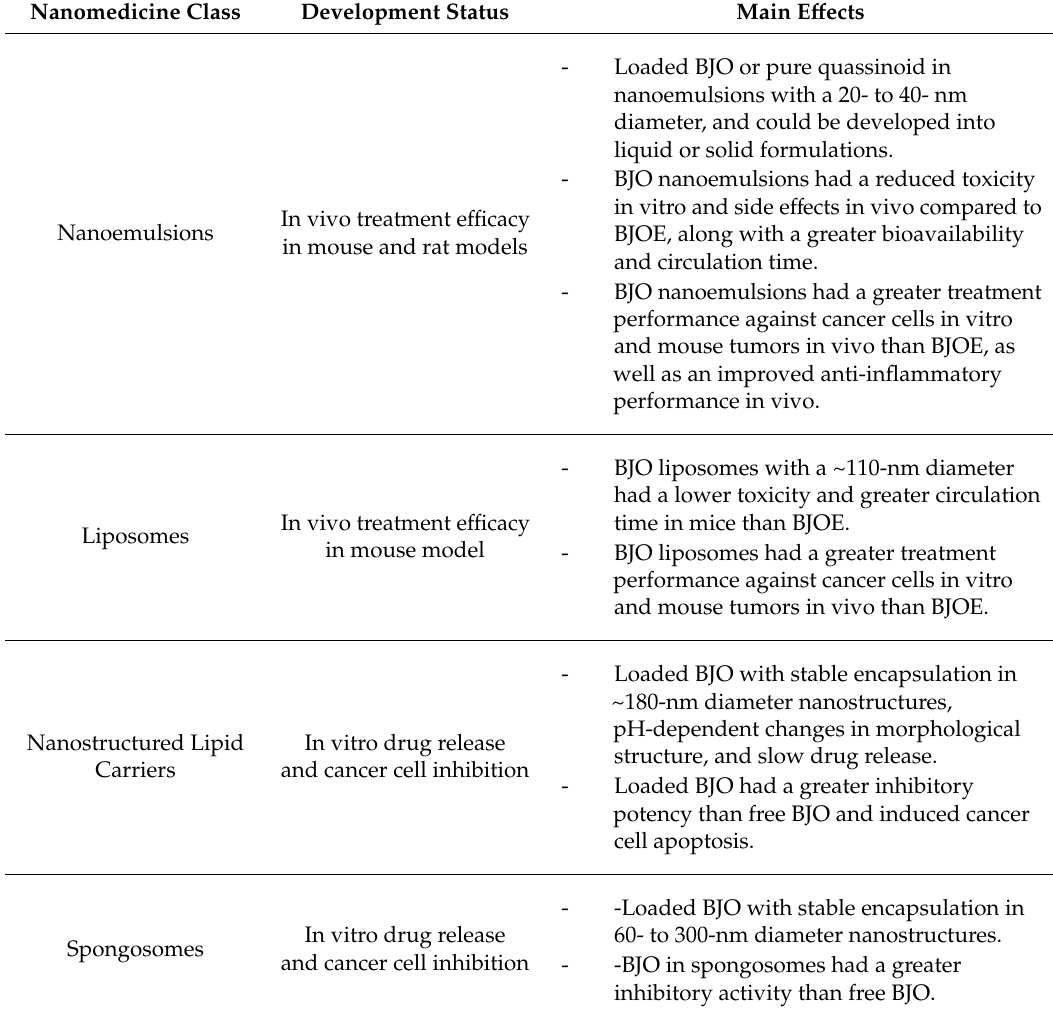
Table 1. Status of di ff erent nanomedicine delivery strategies under development for BJO and / or purified quassinoid